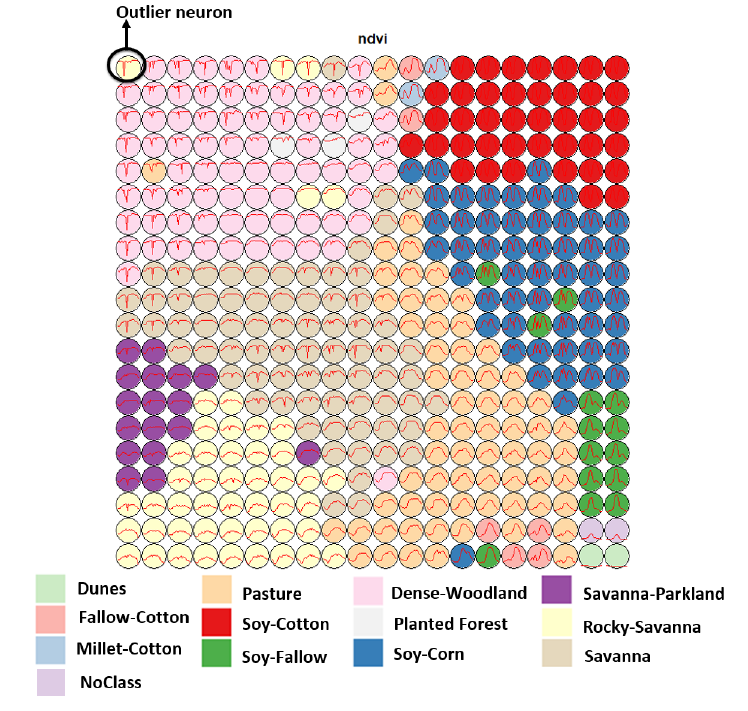
Figure 5. SOM map for Cerrado training samples (source: